Question: State the chart type depicted above.
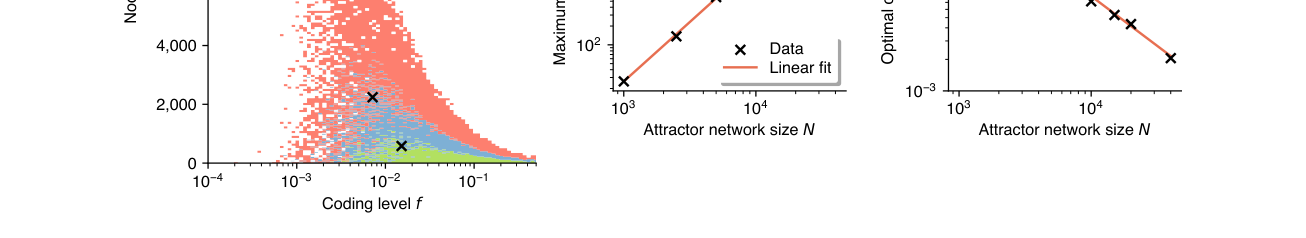
Answer: line